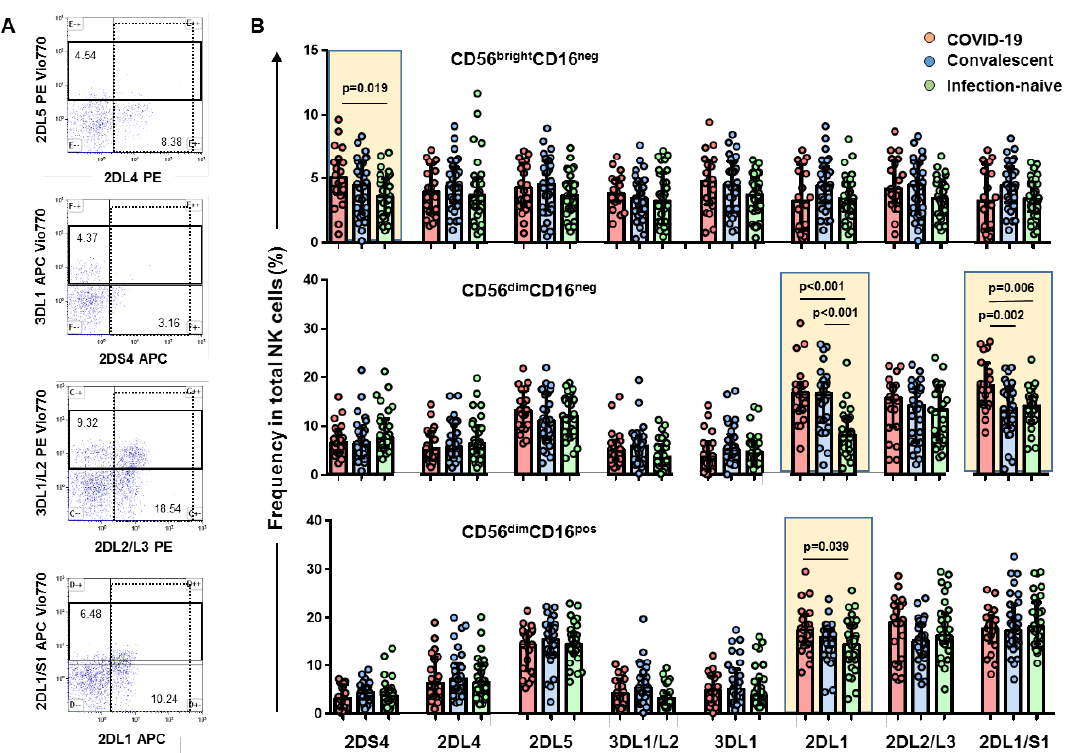
Figure 2. Frequency of NK cell subsets positive for KIR receptors. ( A ), Representative flow cytometry plots of one infection-naïve individual showing the gating strategy for KIR receptors: 2DS4, 2 DL4, 2DL5, 3DL1/L2, 3DL1, 2DL1, 2DL2/L3, and 2DL1/S1 in CD56dimCD16neg NK cell subset showing the percentage of cells for each KIR. ( B ), Bar plot showing cumulative data regarding the frequency of CD56 bright CD16 neg , CD56 dim CD16 neg , and CD56 dim CD16 pos NK cell subsets for the different KIR receptors in COVID-19 patients (red, n = 20), convalescents (blue, n = 30), and infection-naïve (green, n = 30) individuals. Only statistically significant values are shown in bold when p < 0.05.